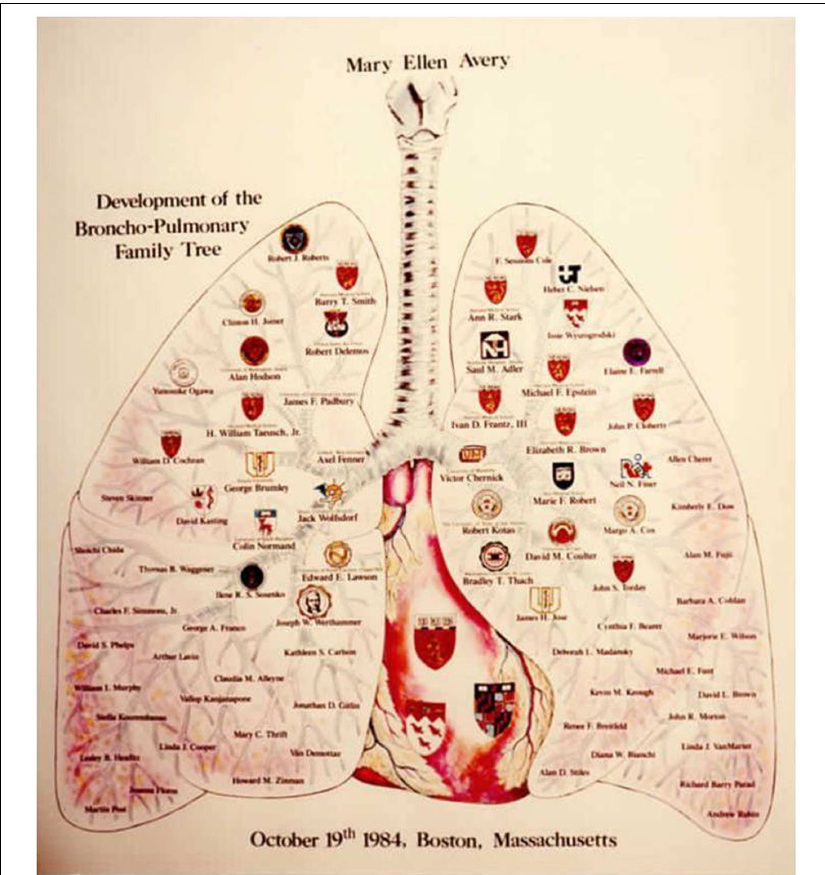
FIGURE 1 | Bronchopulmonary tree illustrating Dr.Avery’s trainees through 1984